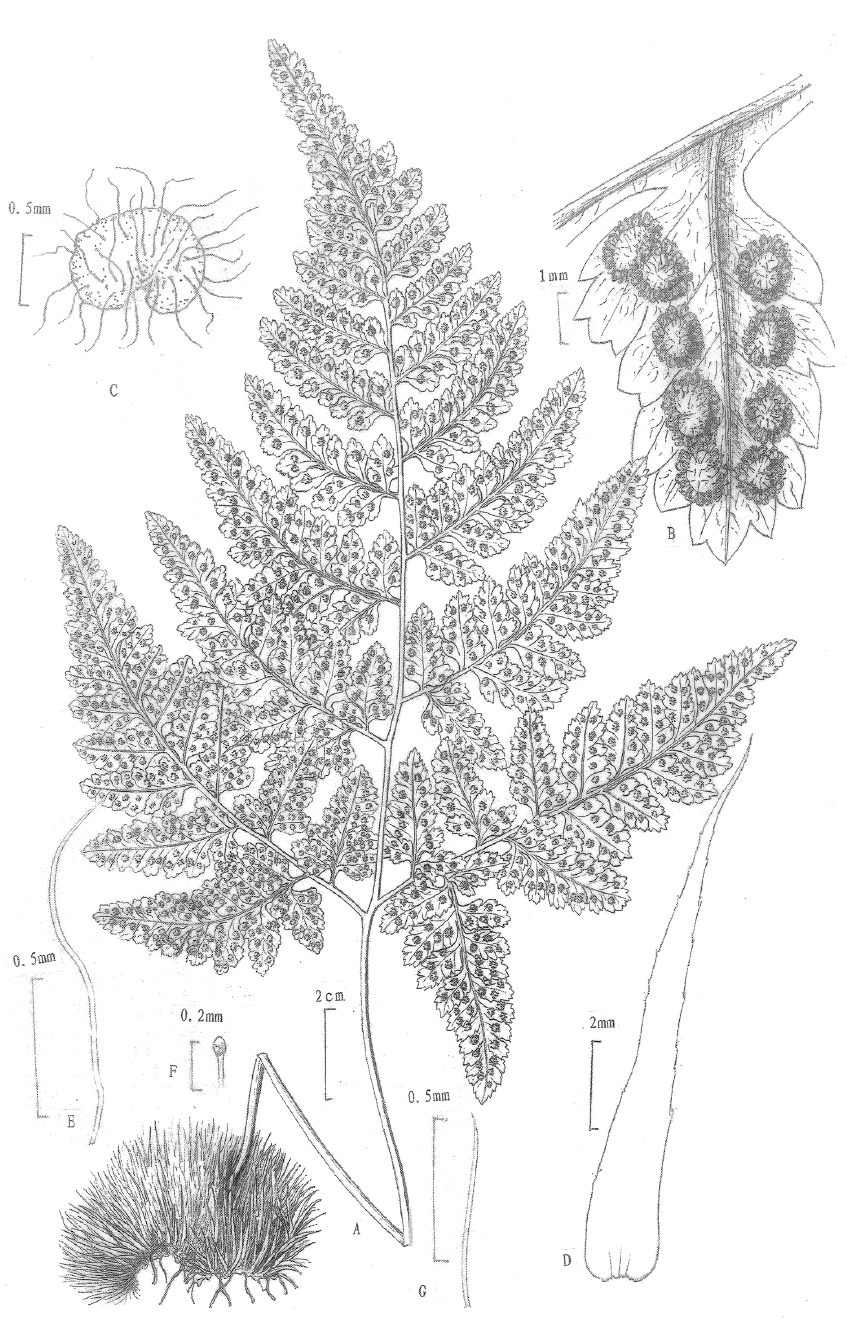
Figure 1. Hypodematium confertivillosum J.X.Li, F.Q.Zhou & X.J.Li, sp. nov. A Habit B Sori on the abaxial surface of pinnules C Indusium with long hairs D Rhizome and stipe base scales E Long hairs from the abaxial surface of fronds F Rod-shaped glandular hairs from the abaxial surface of fronds G Hairs from the adaxial surface of fronds (Drawn by Y. B. Sun & J. X.